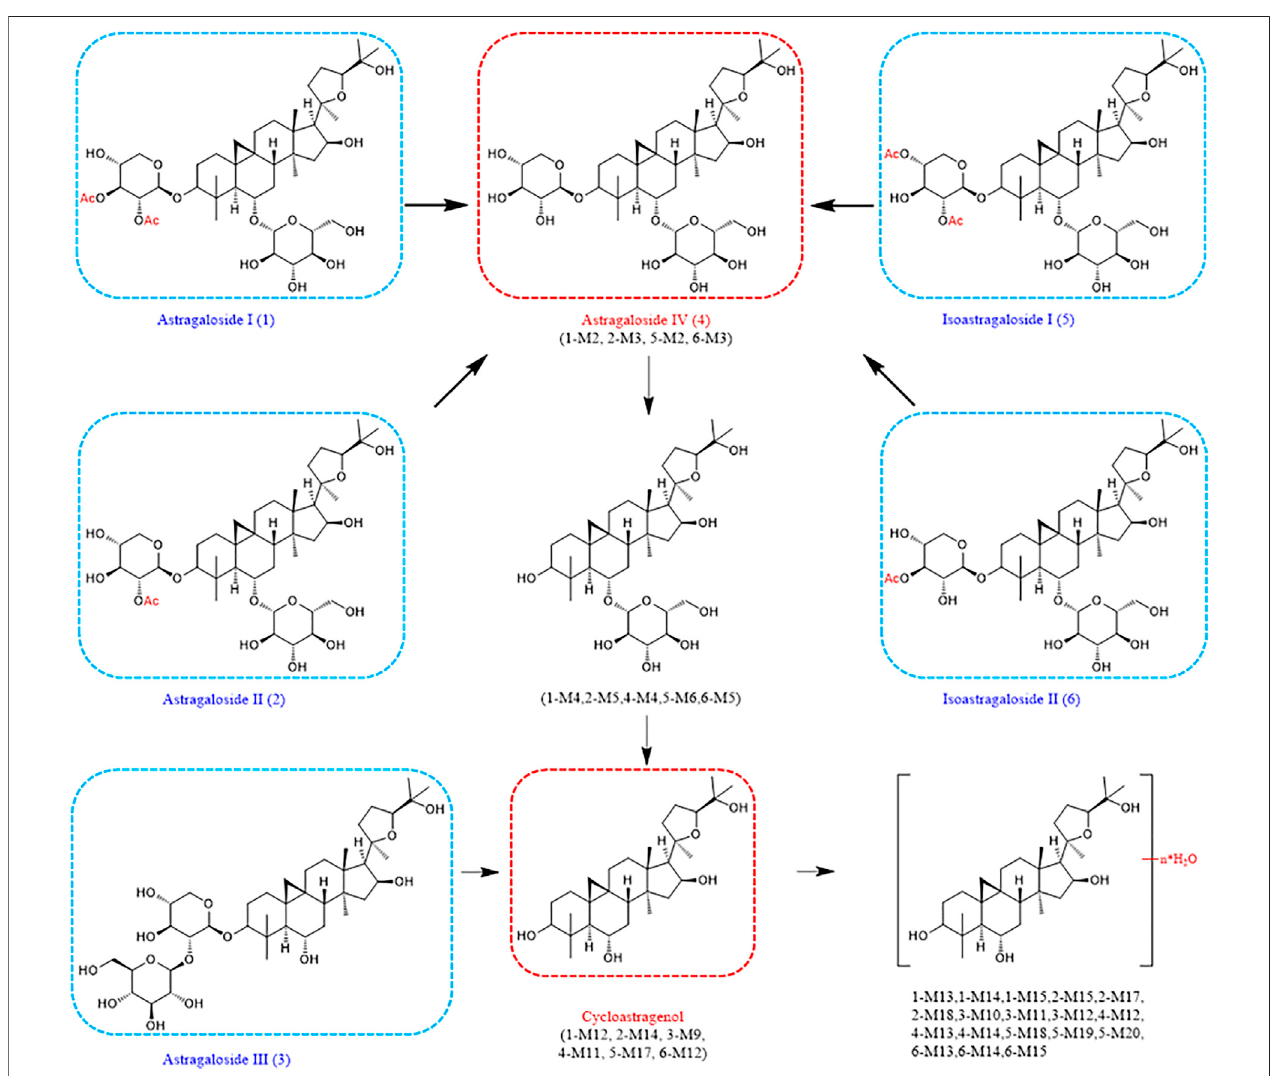
FIGURE 6 | Metabolic pathways of compounds 1 – 6 in Astragalus mongholicus Bunge.